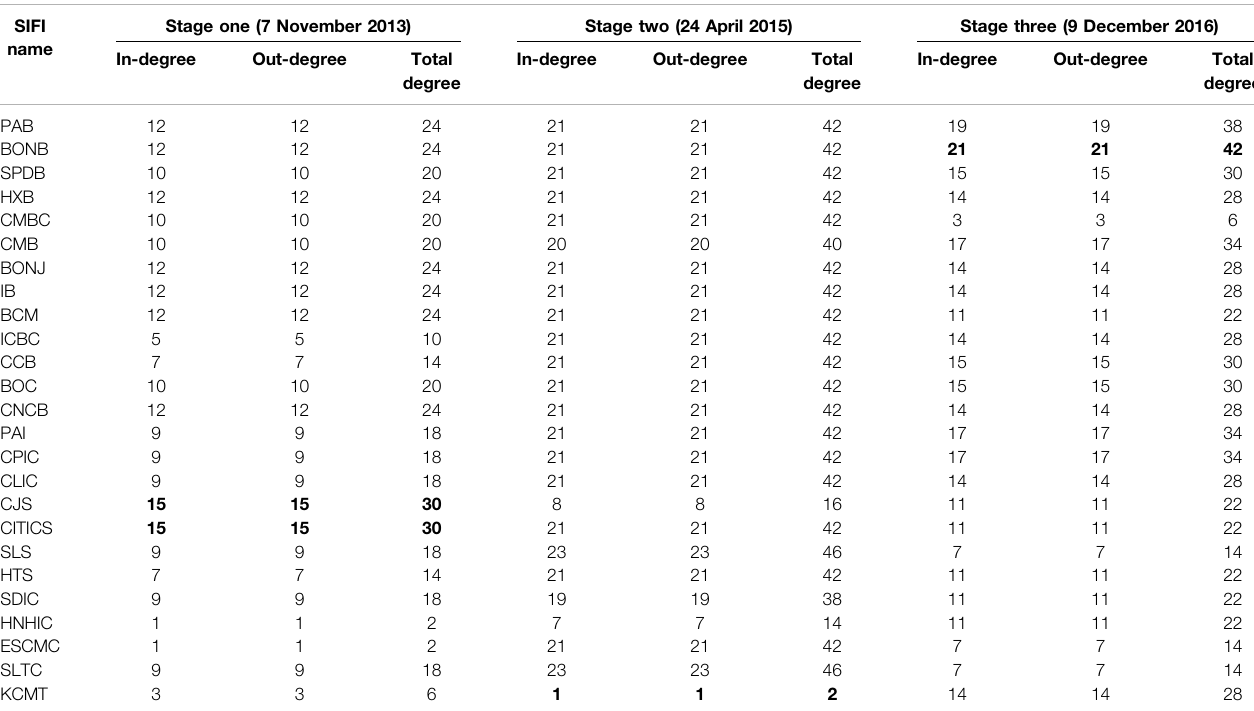
TABLE 5 | Degree of the Chinese